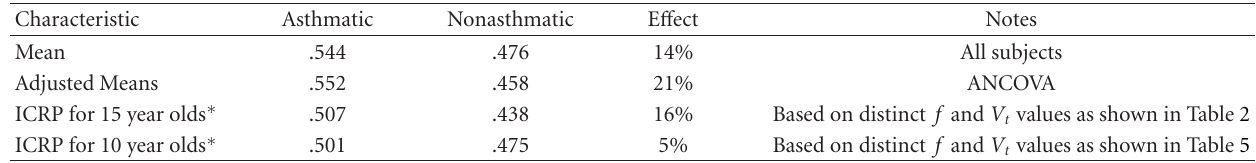
Table 3: Summary of total deposited fraction values.